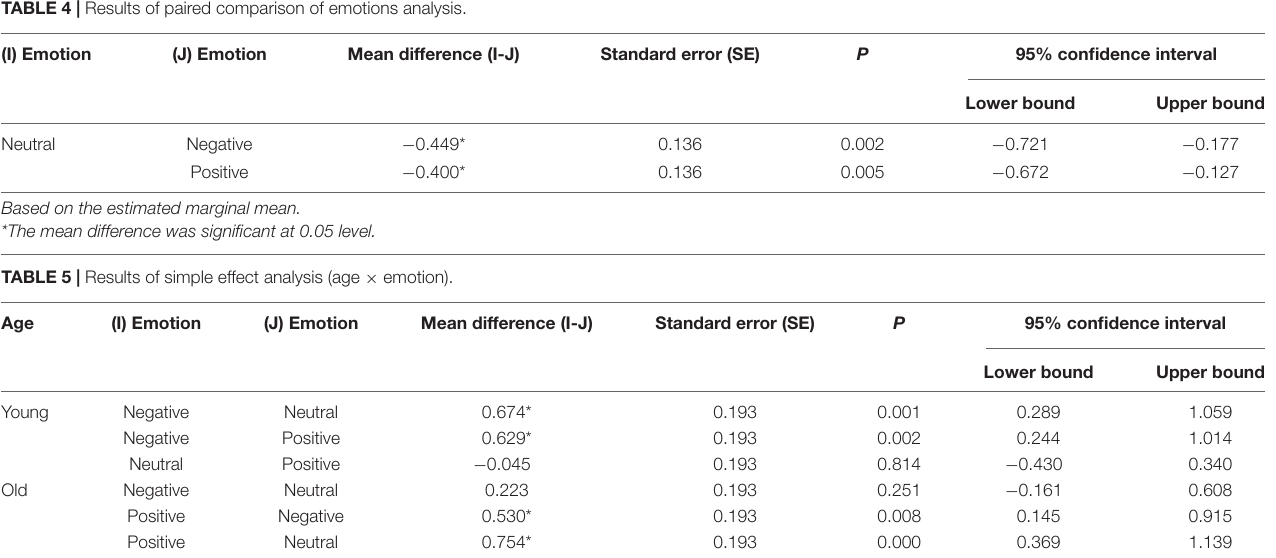
TABLE 4 | Results of paired comparison of emotions analysis.